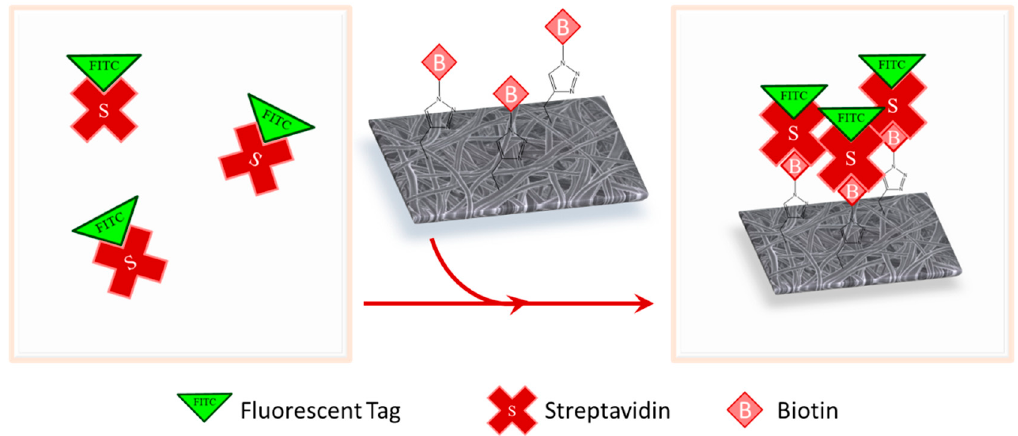
Figure 4. Streptavidin-biotin binding schematic: Fluorescently tagged streptavidin in aqueous solution binds with the immobilized biotin on the nanofiber surface once the membrane is added to the solution.